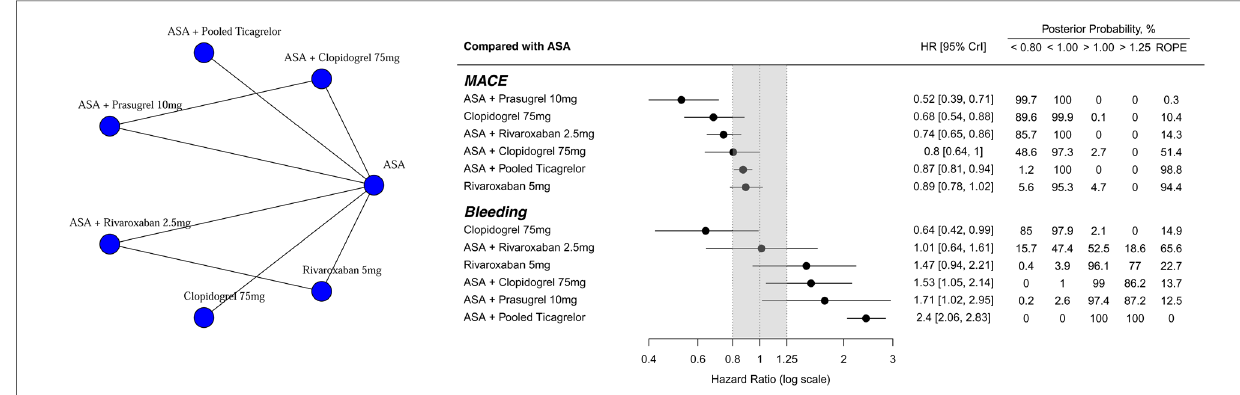
FIGURE 2 Network plot. Treatment effects compared with ASA on MACE and Bleeding outcomes, ordered according to underlying SUCRA values. HR below 1.0 favors the experimental treatment. On the left, treatment names are depicted. In the middle, forest plot shows each treatment effect median and 95% credible intervals. Gray area corresponds to the ROPE (from 0.8 to 1.25 HR). On the right, exact effect sizes along with posterior probabilities are shown. ROPE, region of practical equivalence; HR, hazard ratio.